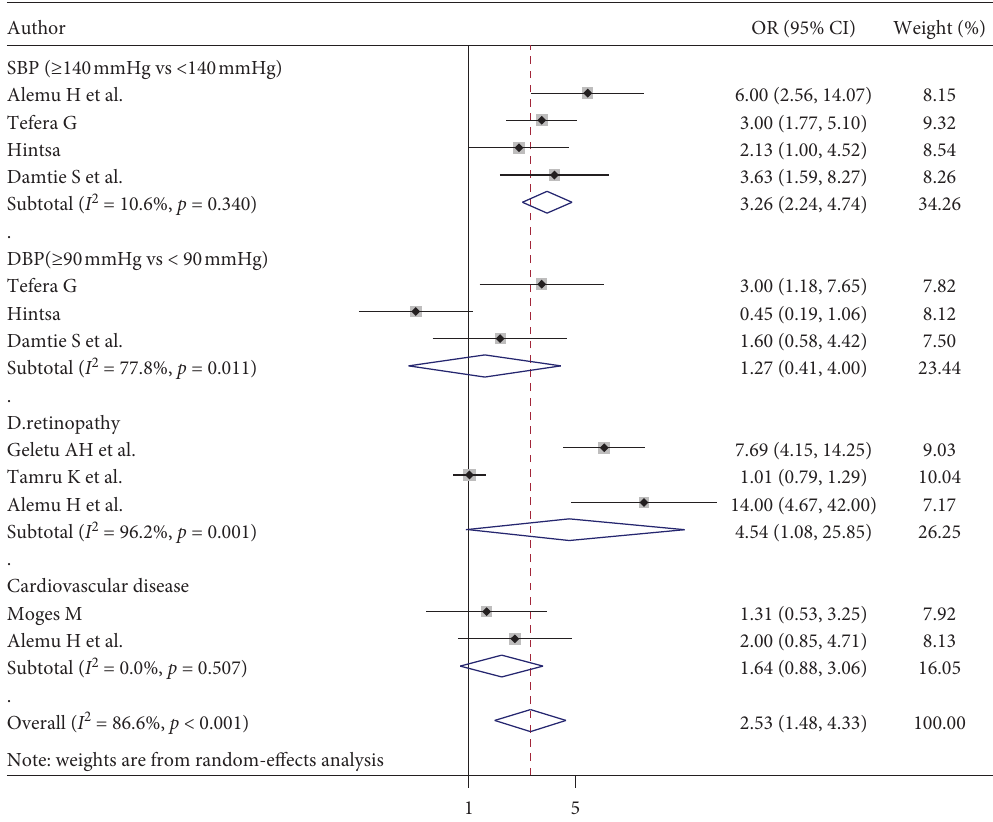
Figure 8: The effect of comorbidity-related factors on CKD inpatients with